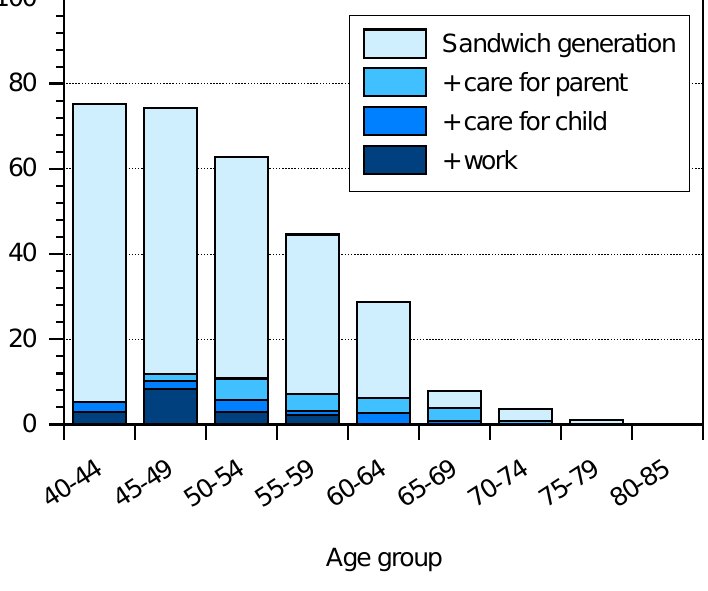
Figure 2 . Sandwich constellations of men (percentages by age